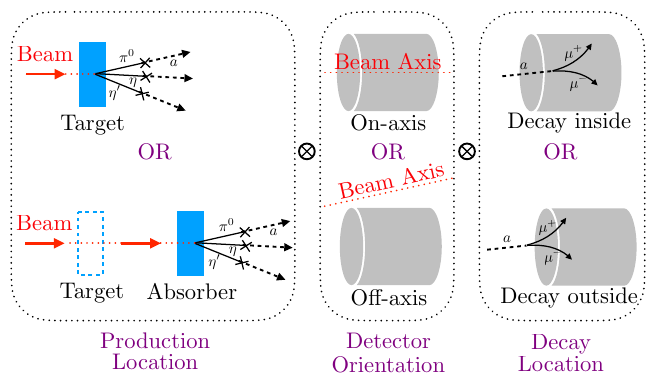
Figure 1 . In this schematic diagram, the three columns show possible production locations, beam directions with respect to the detector, and decay locations. The axions can be produced from the beam at the target or at the absorber. The detector, shown by the gray cylinder, may be on- or off-axis from the beam. Lastly, the axion may decay inside or before entering the